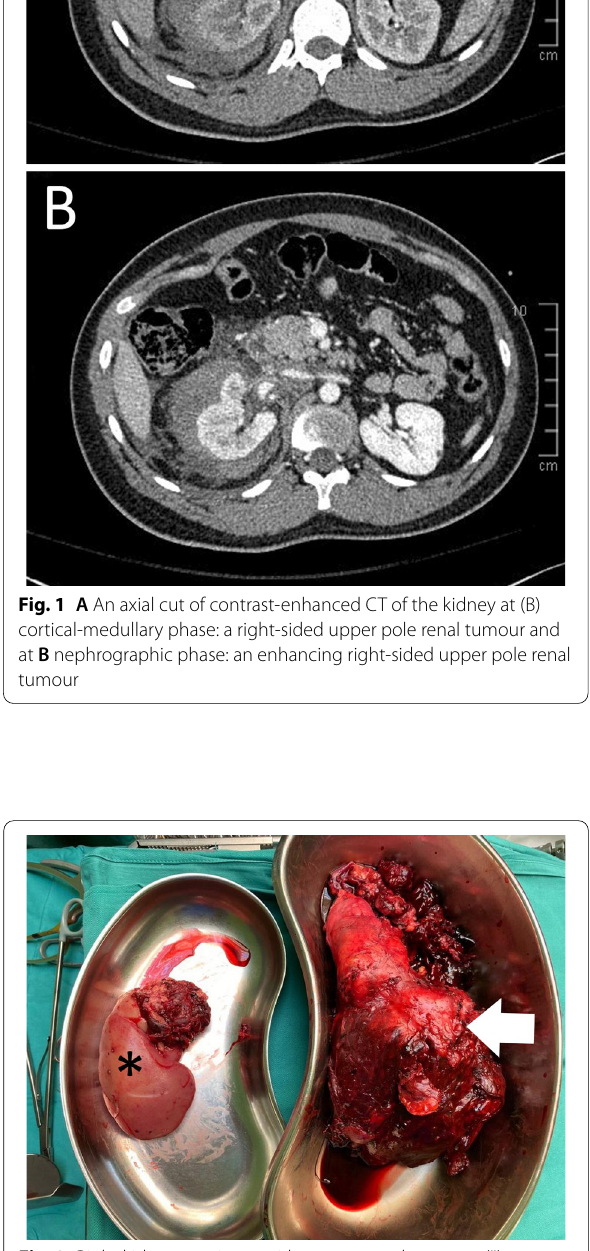
Fig. 2 Right kidney specimen with an upper pole tumour (*). Peri-renal fat tissues were seen with the surrounding hematoma